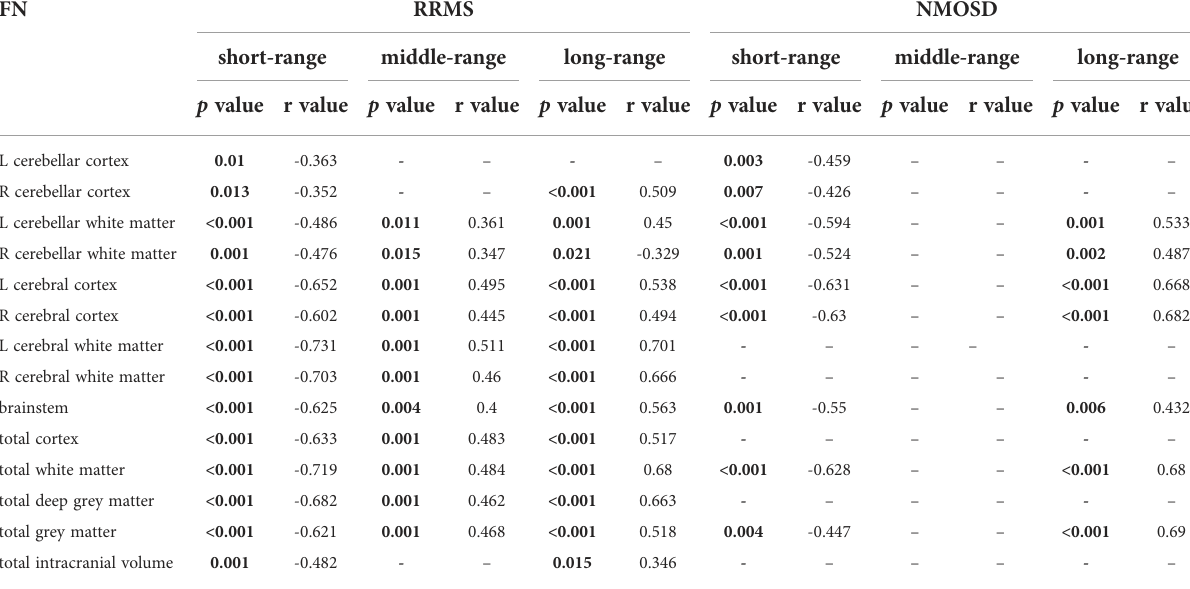
TABLE 3 The correlation between FN of different fi bers connections lengths and the total brain tissue volume in RRMS and NMOSD. FN RRMS